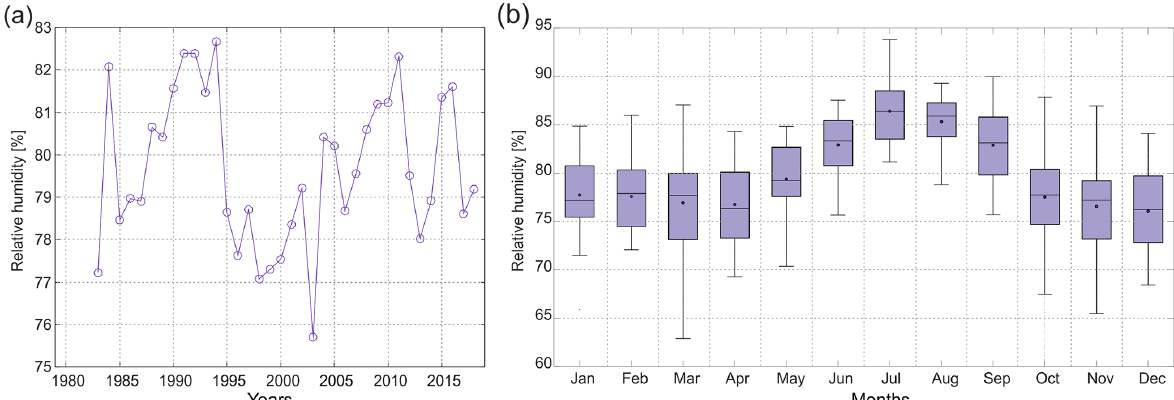
Figure 3. (a) Variability of an annual mean of relative humidity in 1983–2018 at Hornsund. (b) Variability of mean monthly relative humidity in 1983–2018 at Hornsund.